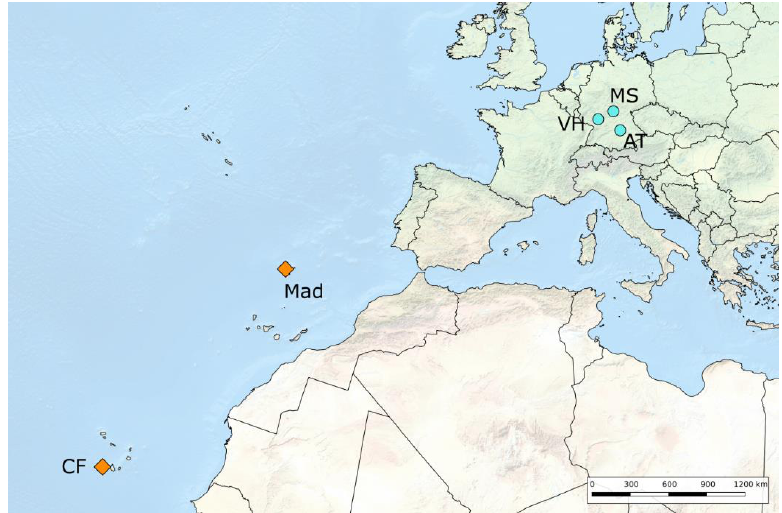
Figure A1. Map of localities of sampled wild H. euphorbiae F0 individuals used to breed progeny for the experiments. Orange diamonds: Het ecotype, blue circles: Hee . Locality codes according to Table 1. Map built using QGIS 2.18.4 (qgis.org, accessed on 15 Mrch 2021), edited using Inkscape 1.0.1 (inkscape.org, accessed on 15 Mrch 2021).